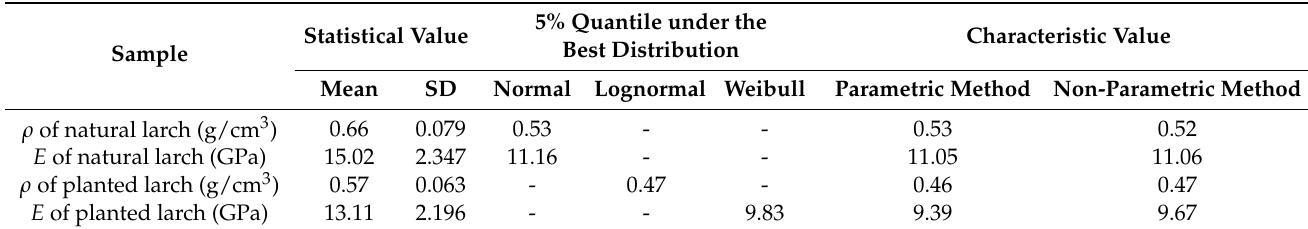
Table 6. Characteristic values of density and MOE for the larch dimension